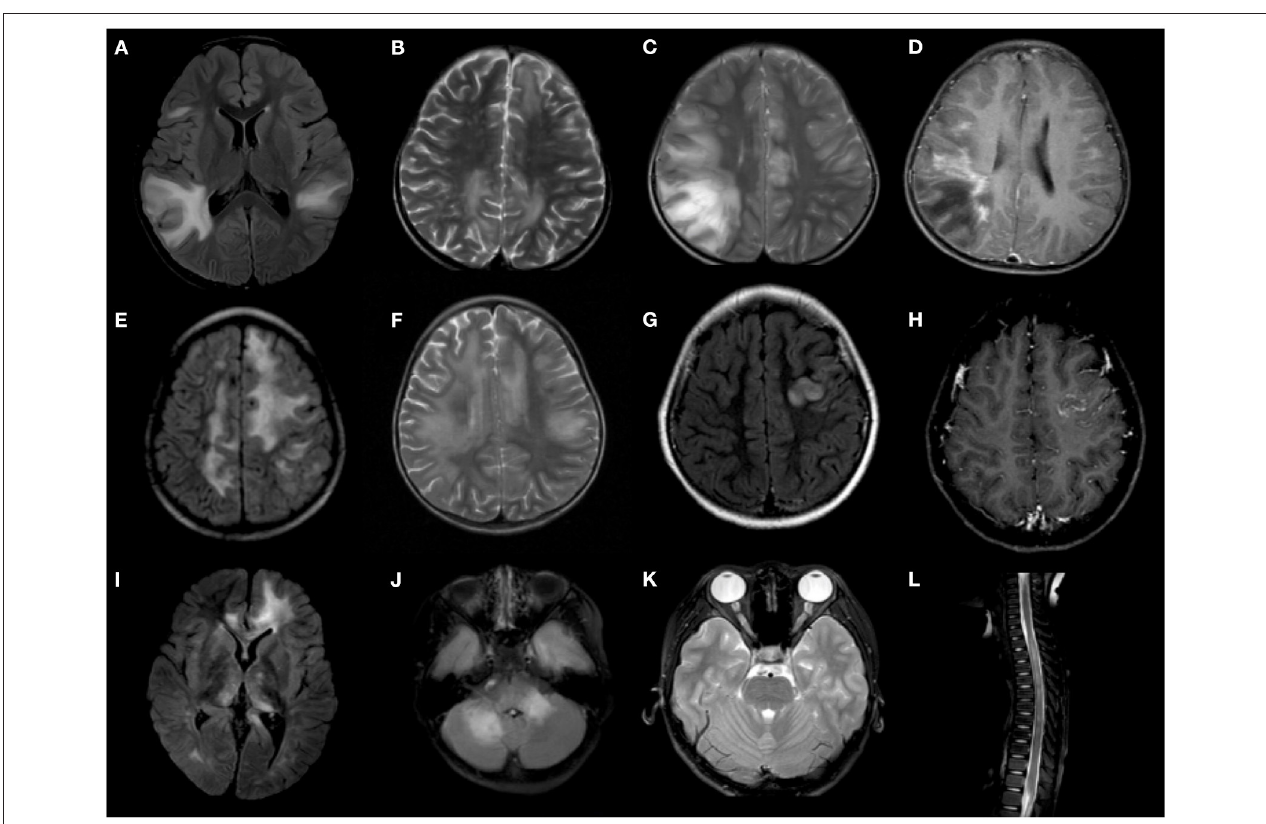
FIGURE 2 | Representative radiological features of MOG-ab-positive patients. (A–D) Confluent, poorly demarcated lesions in gray and white matter. (E,F) Extensive, confluent, essentially symmetric white matter lesions (leukodystrophy-like). (G,H) Unilateral cortical lesion. (I) Deep gray matter involvement. (J) Cerebellum and cerebellar peduncle lesions. (K) Bilateral optic nerve involvement. (L) longitudinally extensive transverse myelitis